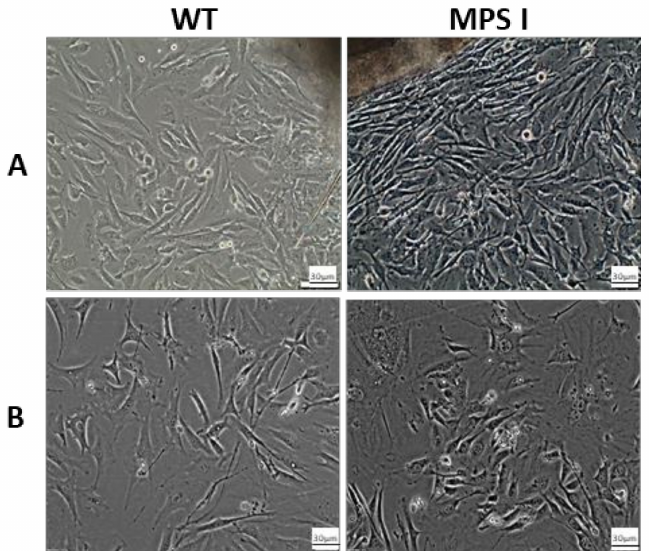
Figure 1. Morphology of wild type (WT) and mucopolysaccharidosis I (MPS I) murine fibroblasts. Microphotographs represent different time points during cell culture. Panel ( A ) show fibroblasts that migrated from the skin explants on Day 10 after the beginning of culture. Panel ( B ) show murine fibroblasts after the fourth